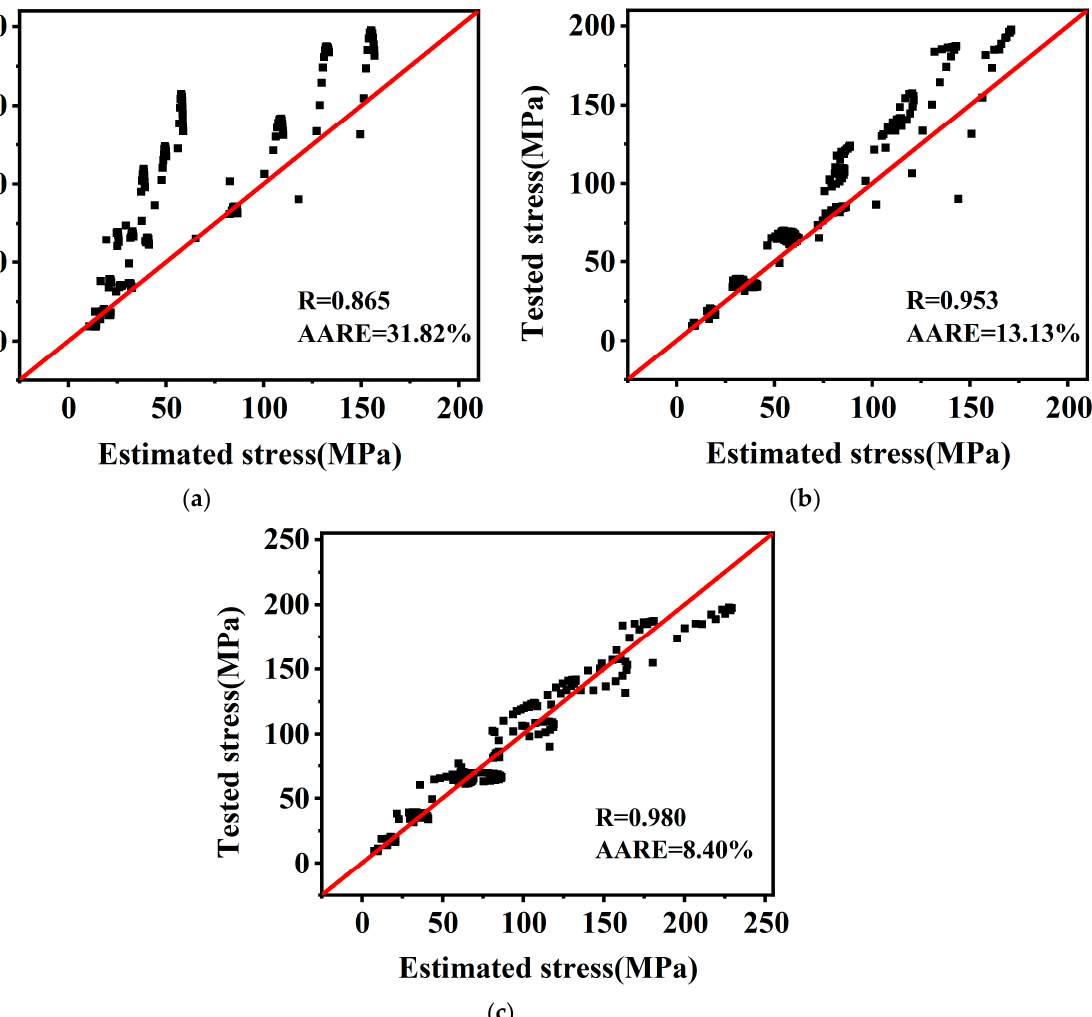
Figure 13. Correlation between tested and estimated flow stresses: ( a ) O–JC model; ( b ) N–JC model; ( c ) NM–JC model.